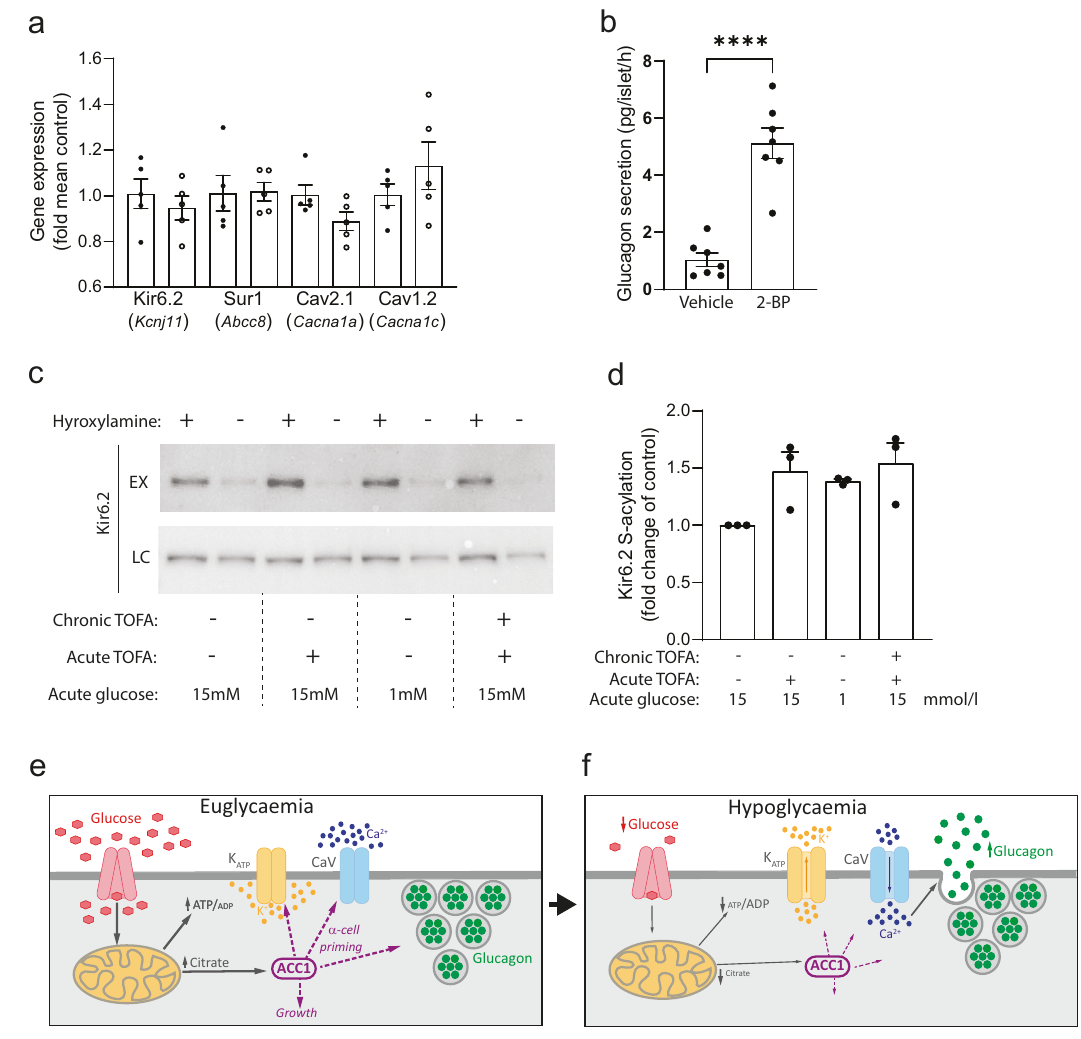
Fig. 7 The KATP channel subunit Kir6.2 is S-acylated in alpha cells. a mRNA expression of KATP and CaV channel subunits, assessed by RT-PCR using cDNA from FACS-enriched primary alpha cells from control (black circles) and gluACC1KO (white circles) mice. b Pancreatic islets isolated from wild-type C57BL6/J mice were pre-treated with vehicle or 100 µ mol/l 2-bromopalmitate (2-BP) for 1 h to block protein palmitoylation, before glucagon secretion assays were run. Data from n = 7 independent islet preparations analysed by t-test. **** P < 0.0001. c - d aTC9 cells were cultured for 22 h with 15 mM glucose and either vehicle or 25 mmol/l TOFA (Chronic TOFA), followed by a subsequent 2 h incubation with 1 mM or 15 mM glucose, with vehicle or TOFA (Acute TOFA), before lysis. S-acylated proteins were captured in a hydroxylamine-dependent manner using acyl-biotin exchange (ABE) chemistry. Western blotting for Kir6.2 was performed using ABE eluted samples (EX), with input protein lysates as a loading control (LC). c Representative western blot from one experiment. d Quanti fi cation of western blotting band intensity from n = 3 independent experiments. Each EX + band was normalised to the respective LC + band. Data presented as fold-change (with mean ± SEM) and analysed by Mann – Whitney U test. e , f Proposed model for the role of ACC1- coupled signalling in alpha-cell function. During euglycaemia ( e ), ACC1 acts to prime the alpha-cells for secretion, maintaining KATP and CaV channel competency, as well as adequate alpha-cell growth and glucagon content. During a hypoglycaemic stimulus ( f ) glucagon secretion is triggered. In alpha- cells lacking ACC1 activity, glucagon secretion in response to low-glucose concentrations is impaired due to defects in KATP and CaV channel activity, alpha-cell size/number and glucagon